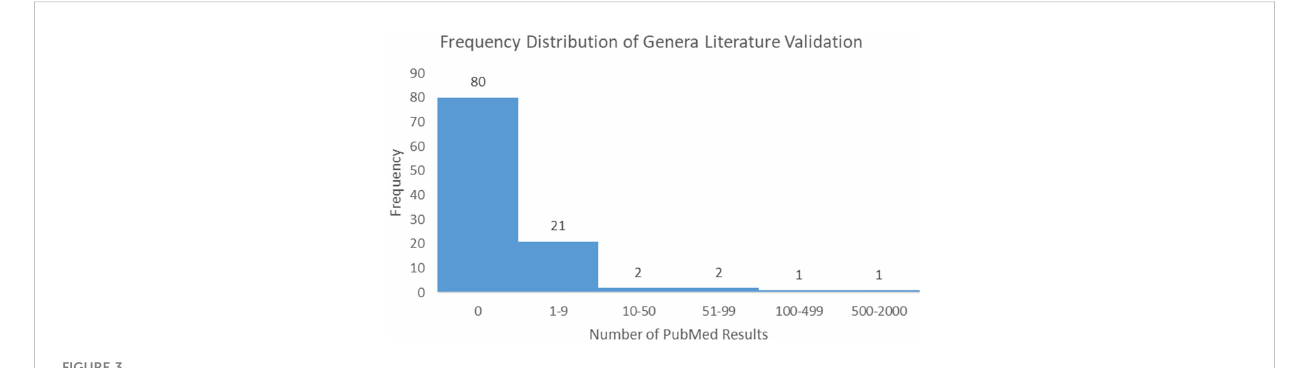
FIGURE 3 Frequency distribution of PubMed results for genera and cancer.